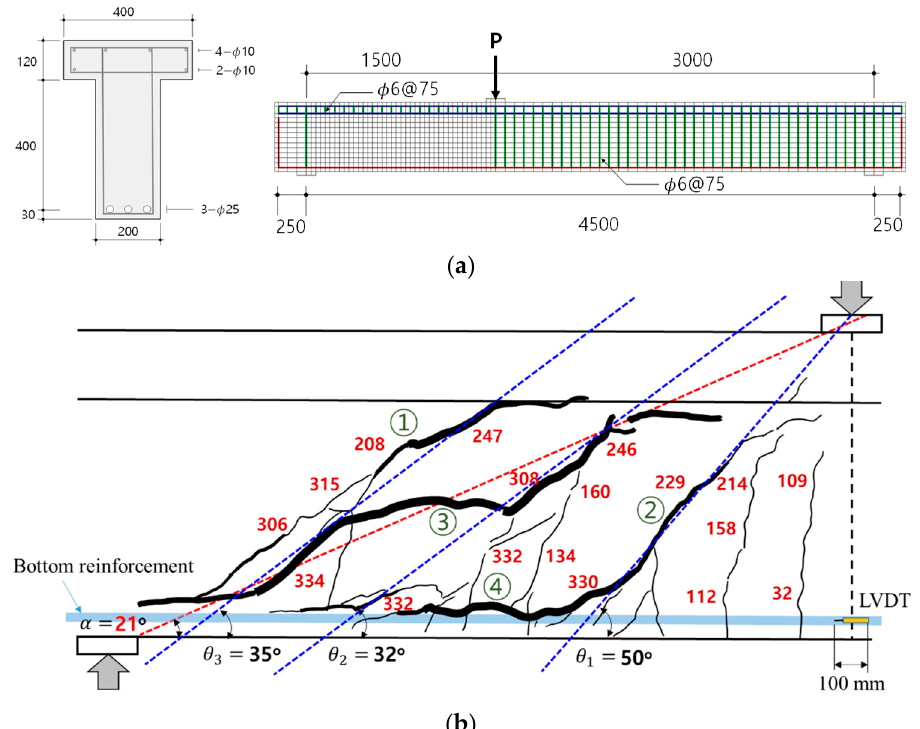
Figure 1. Specimen layout and crack pattern. ( a ) Cross-section, geometry, and reinforcements of the SFRC beam. ( b ) Failure pattern of the SFRC T-beam during the three-point bending test (kN). Because the angle of inclination rotates under different loading/unloading conditions, the angle was developed vertically (under flexure); it was then extended and rotated